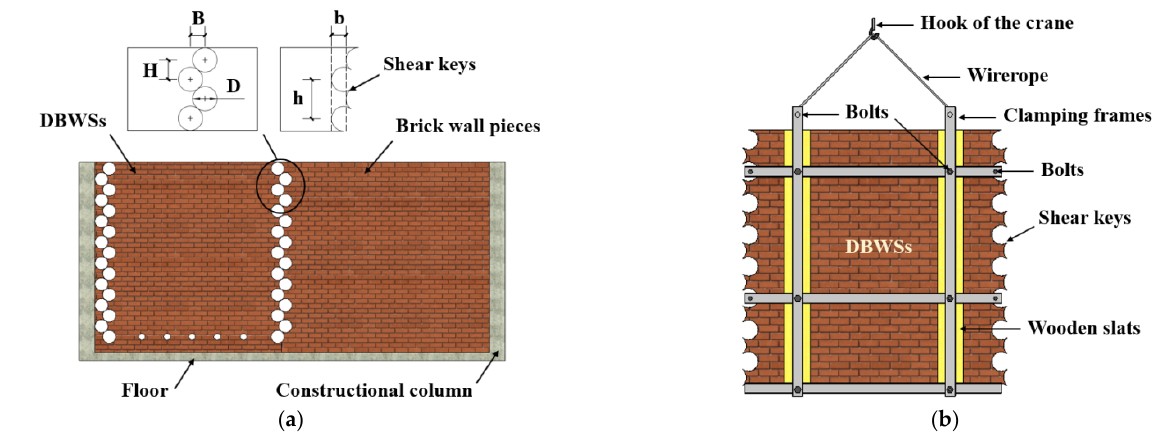
Figure 1. Disassembling details: ( a ) the coring machine to form holes at both sides of the DBWSs; ( b ) the clamping frames details. Table 1. The recommended value for diameter, the distance of holes, and the dimension of shear keys/mm